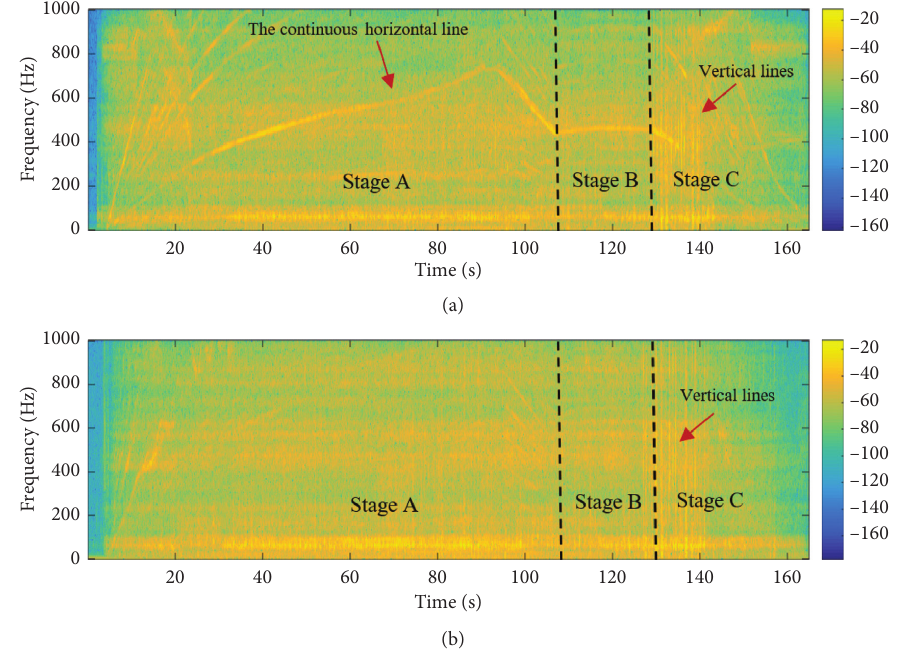
Figure 7: The spectrogram of bogie frames’ full signals under the constant speed case of 115km/h: (a) motor bogie frame and (b) trailer bogie